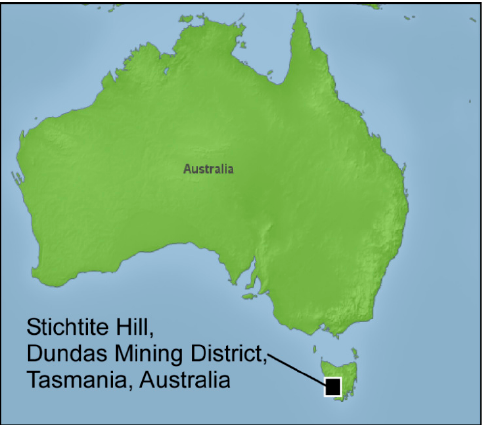
Figure 1. Sample location map, showing the location of Stichtite Hill and the Dundas Mining District, Tasmania, Australia (Black Square). Minerals 2020 , 10 , 215